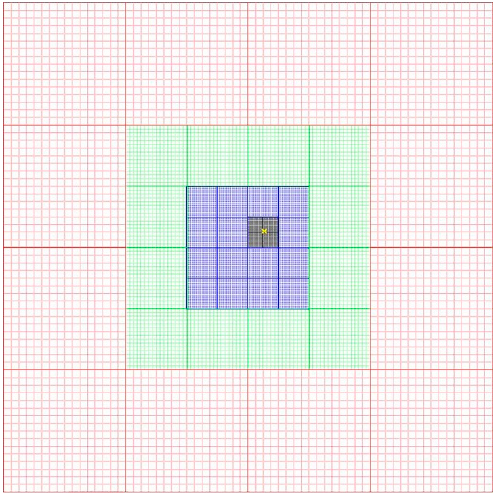
Figure 2. Particular of a Block-Uniform Quadtree (BUQ) grid, with blocks, cells and a maximum resolution seeding point (yellow cross).